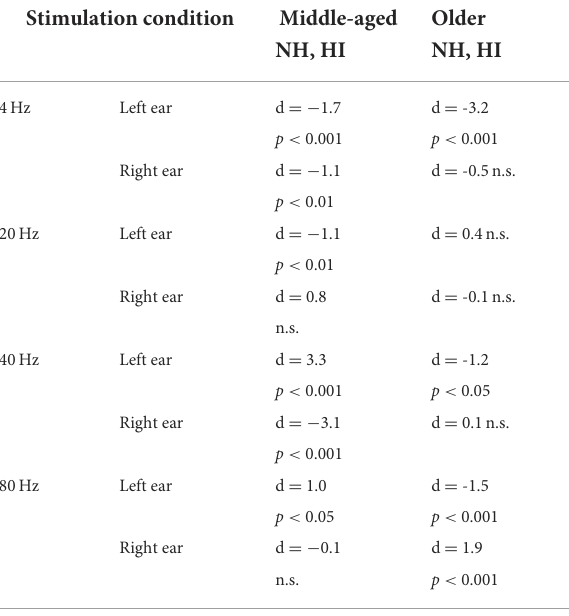
TABLE 2 The results of the statistical comparison between the laterality index of normal-hearing (NH) and hearing-impaired (HI) listeners in different stimulation